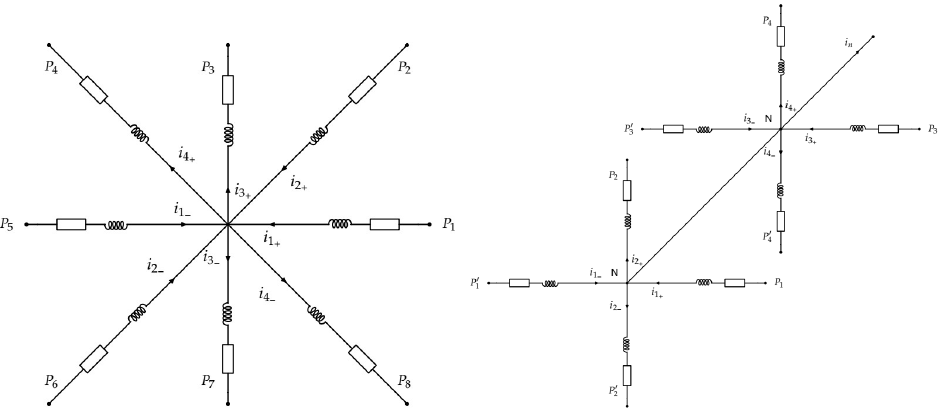
Figure 7. Possible equivalent circuitries for 8-axis bearings: ( left ) single radial bearing/( right ) two radial